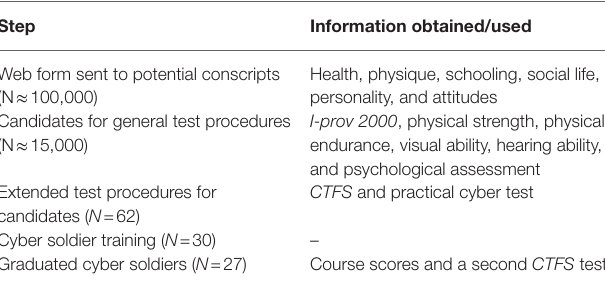
TABLE 1 | Mustering procedures to select conscript cyber soldiers in 2020, and number of conscripts that conducted training. Step Information